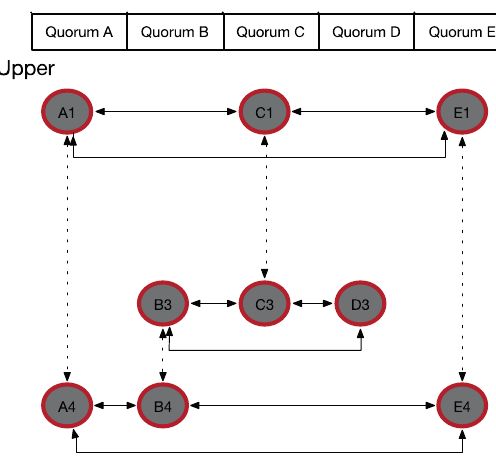
Figure 7. Final result of our